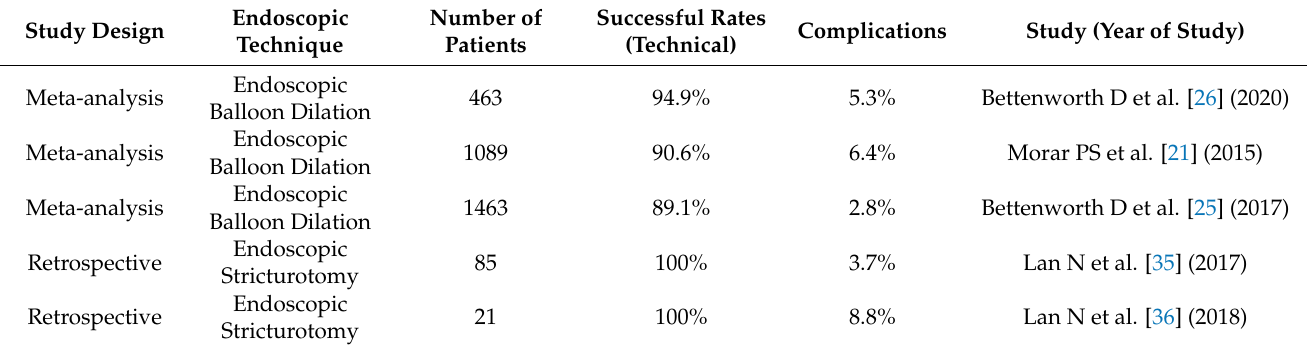
Table 2. Studies about endoscopic techniques of stricturing Crohn’s